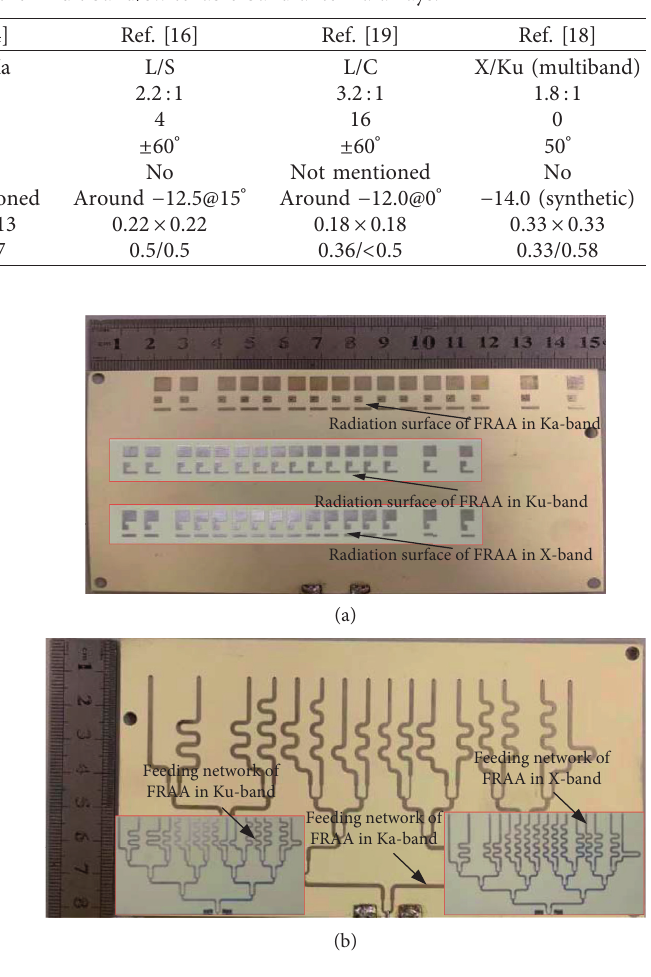
Figure 19: The fabricated 1 × 16 linear irregular FRAA prototype.